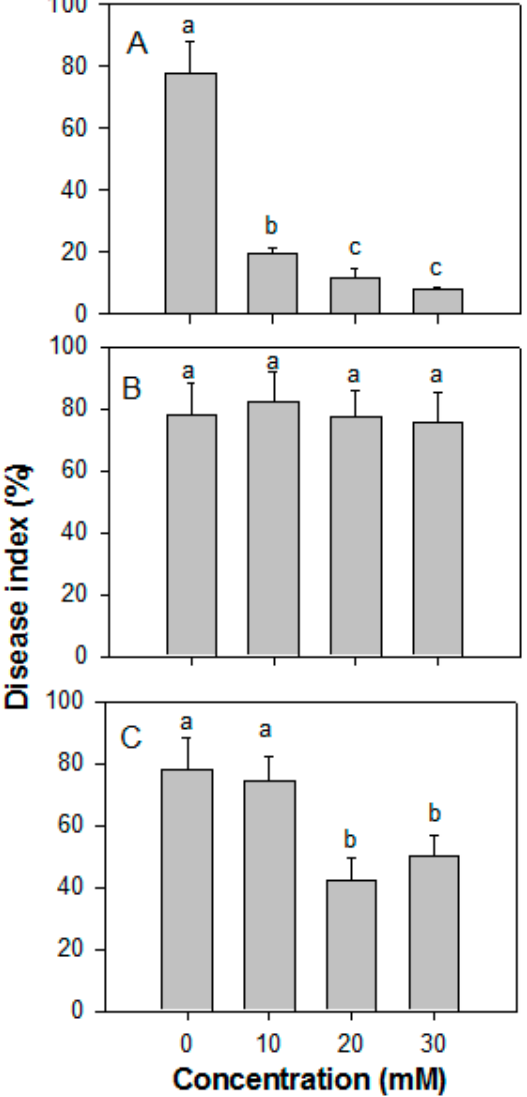
Figure 3. Effect of different ROS at various concentrations on the disease index of papaya fruit inoculated with Colletotrichum gloeosporioides after 10 days of storage at 25 °C. The papaya fruit were treated with ROS and inoculated with C. gloeosporioides . ( A ) H 2 O 2 , ( B ) O 2 − , and ( C ) ∙ OH. ROS, reactive oxygen species. The data were expressed as the means ± SE of three biological replicates. Different letters indicate significant differences.